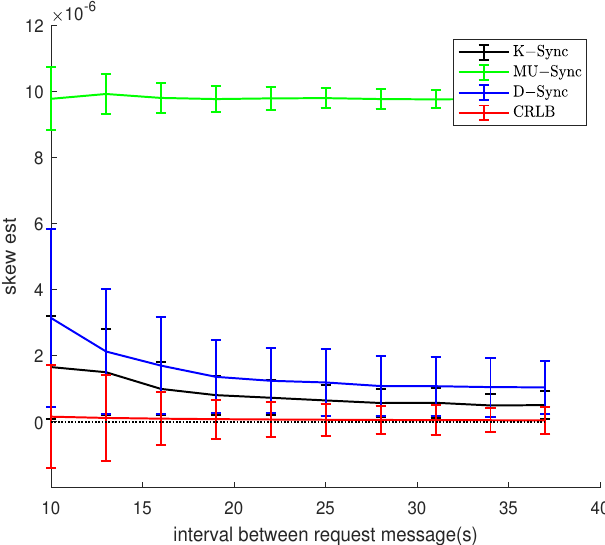
Figure 10. Effect of message exchanges interval (Model